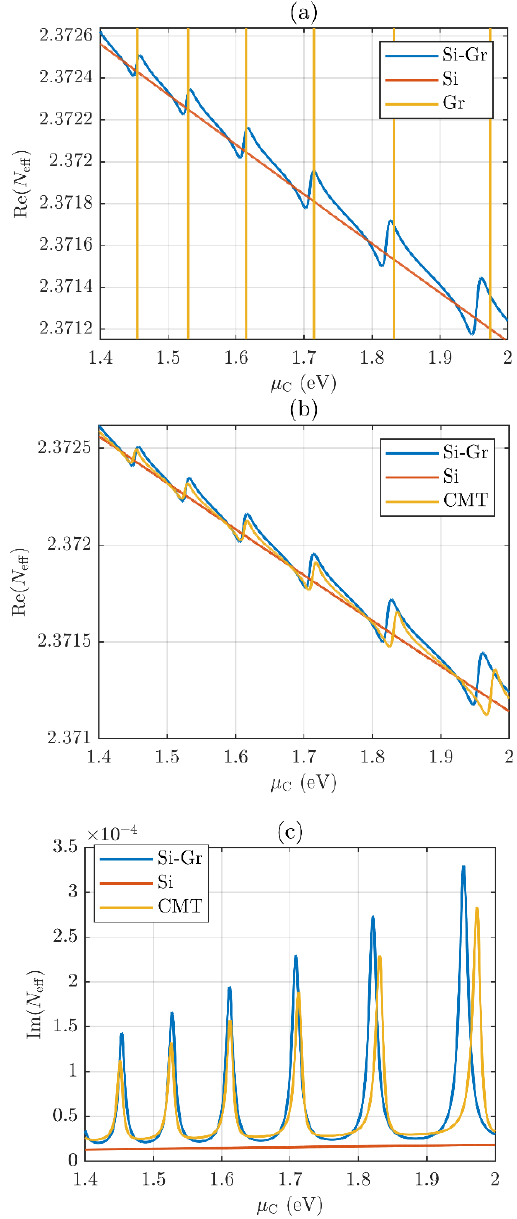
Fig. 4. Modal structure of the Si rib waveguide modulator with a graphene layer with chemical potential µ (rigorous calculation C with COMSOL). The curve labeled as ‘Si - Gr’ describes the fundamental quasi-TE mode (the same mode as ‘Si - Gr’ dependencies in Fig. 3). Only symmetric modes are